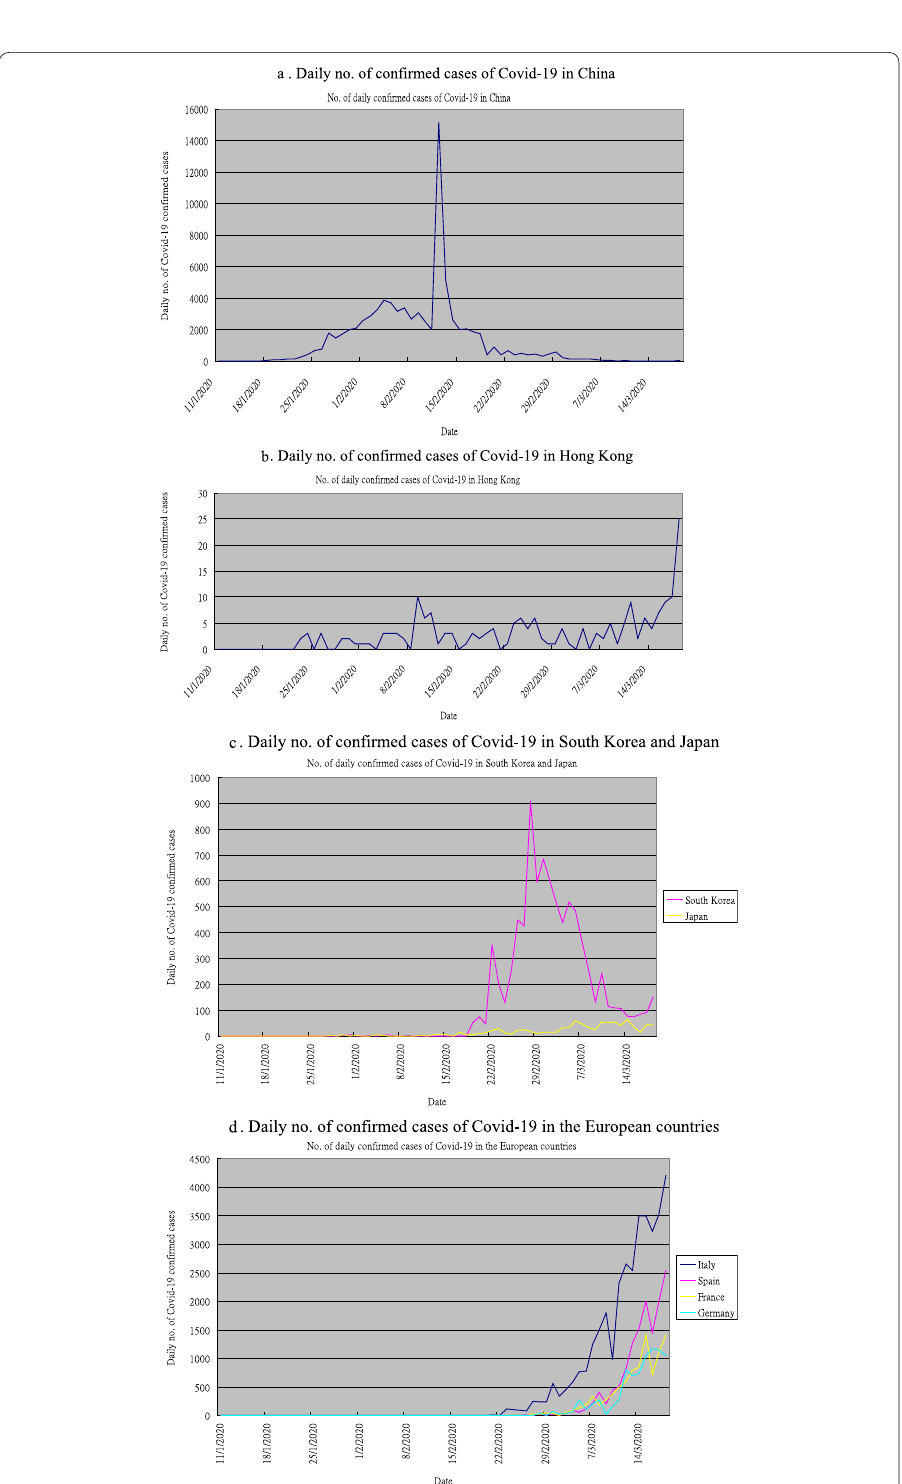
Fig. 1 Daily no. of confirmed cases of Covid-19 in a China, b Hong Kong, c South Korea and Japan and d the European